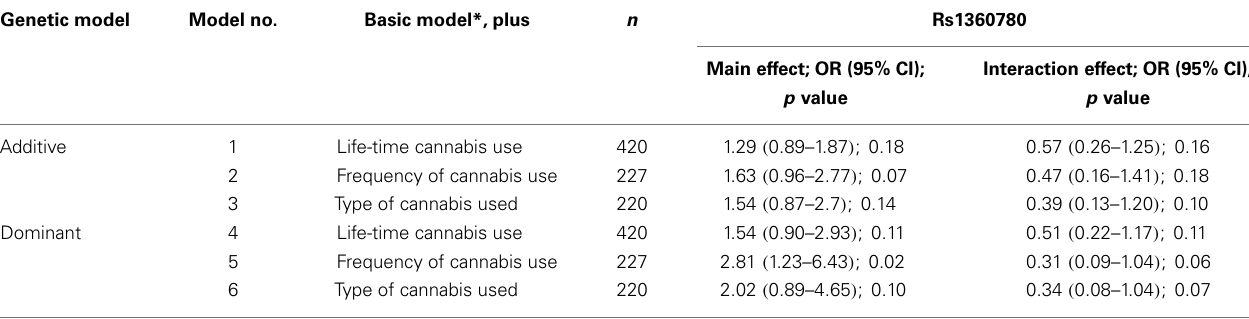
Table 3 | Effect of FKBP5 on psychosis caseness after adjusting for environmental exposures . Genetic